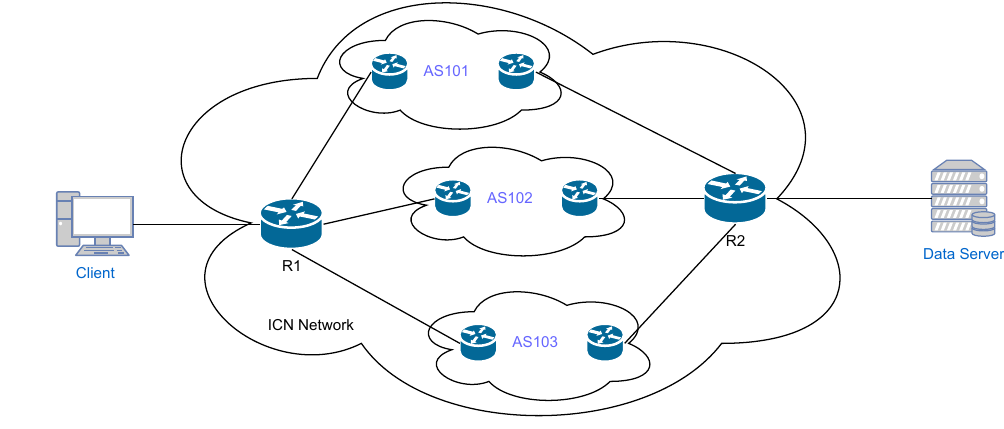
Figure 5. Multipath